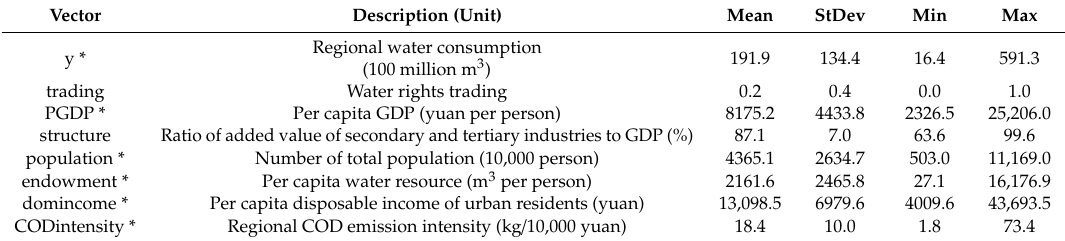
Table 1. Descriptive statistics of all